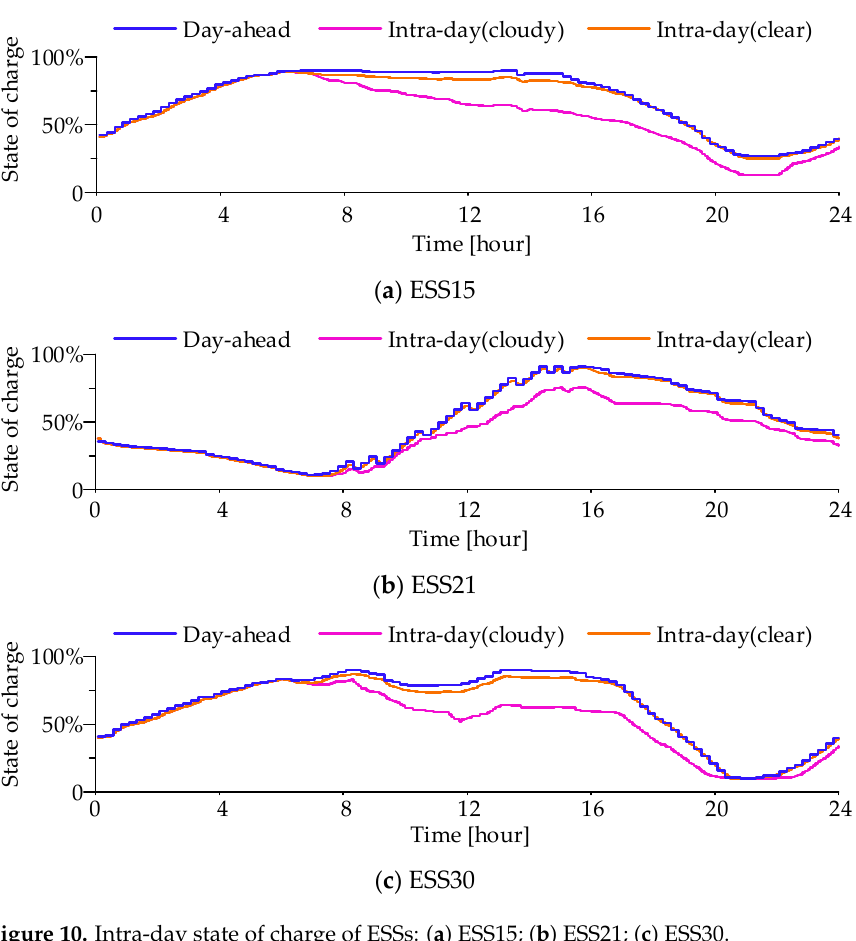
Figure 10. Intra-day state of charge of ESSs: ( a ) ESS15; ( b ) ESS21; ( c ) ESS30.